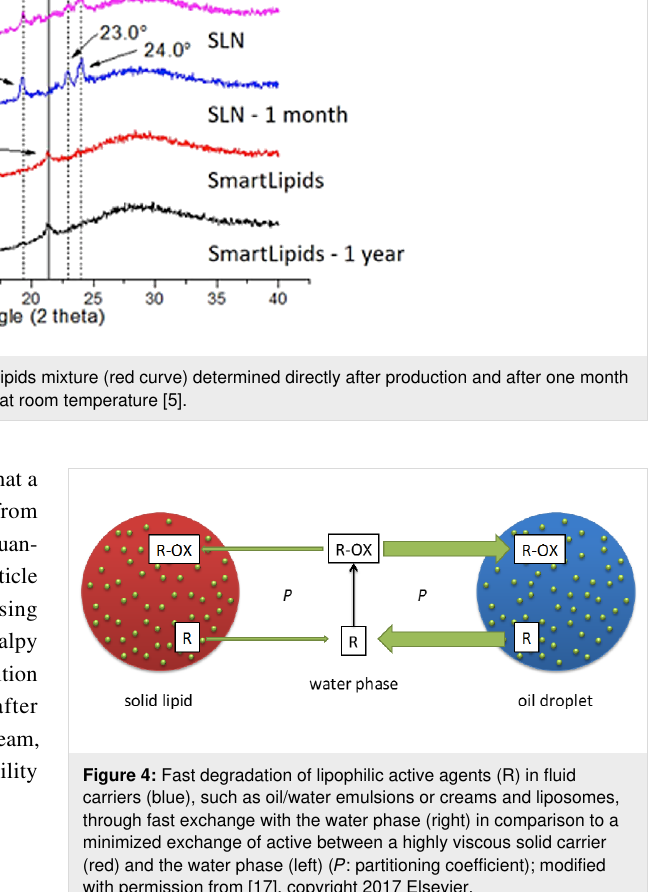
tioned exchange is practically avoided or at least strongly mini- mized [16] (Figure